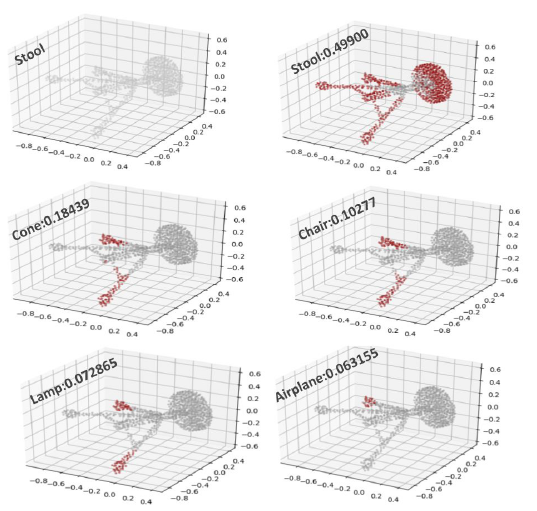
Figure 6. Examples of the CAMs generated from the top 5 predicted classes for the given point cloud with ground-truth as stool. The predicted class and its score are shown above each class activation map. We observe that the highlighted regions vary across predicted